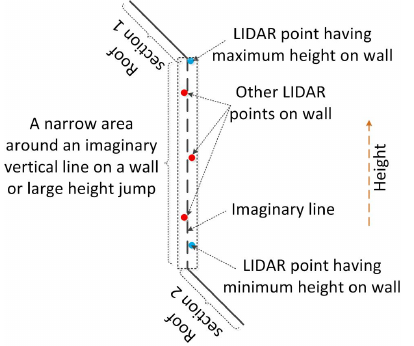
Figure 4: LIDAR points reflected from a narrow area around an imaginary line on a wall or large height jump.